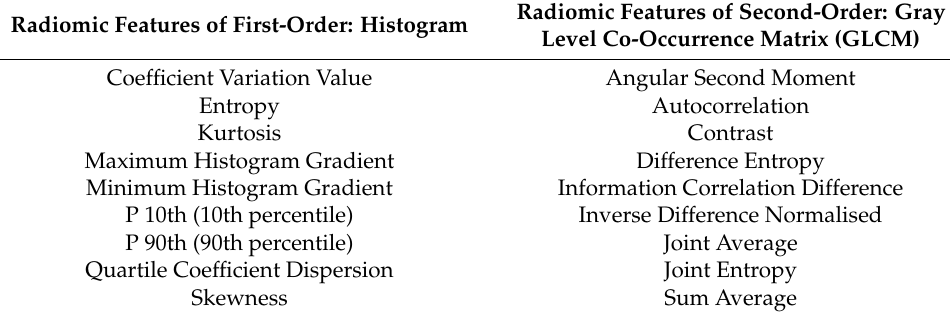
Table A2. List of selected texture features for radiomic analysis. Radiomic Features of First-Order: